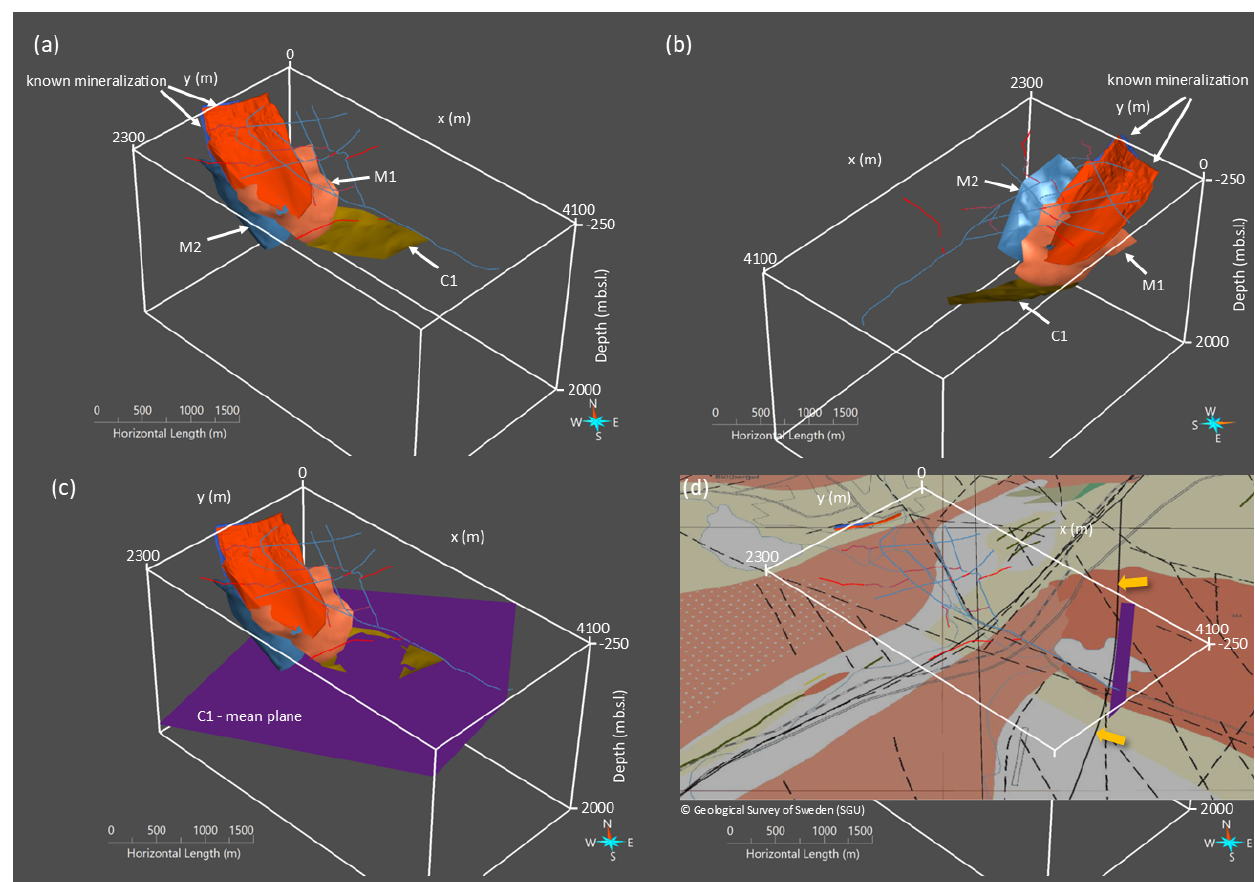
Figure 10. Interpretation of the identified and picked horizons. Panels (a) and (b) show perspective views on the picked horizons and the model of the known mineralization. The crosscutting reflector C 1 is extrapolated using a mean plane (purple plane c ), which intersects with the surface at a mapped fault line (yellow arrows in d ). The view in (d) is identical to (c) but includes a map of the surface geology (courtesy of the Geological Survey of